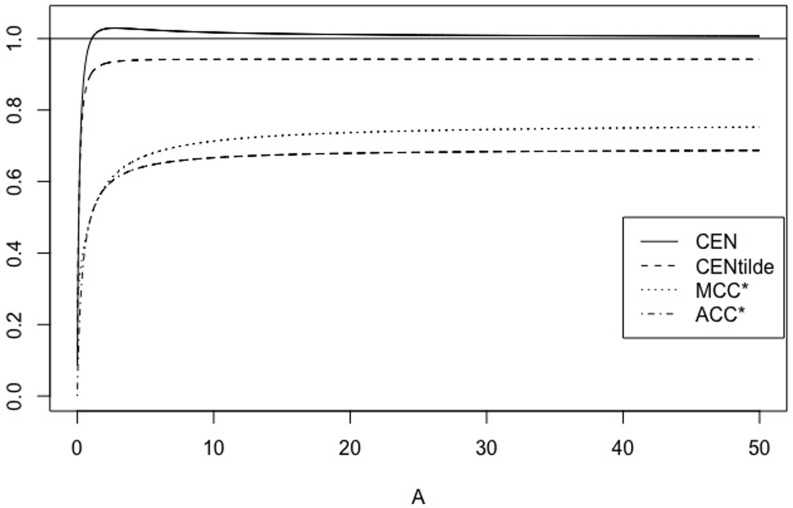
Family YA, r.CEN, MCEN, ACC* and MCC* as function of A > 0 for r = 0.8.